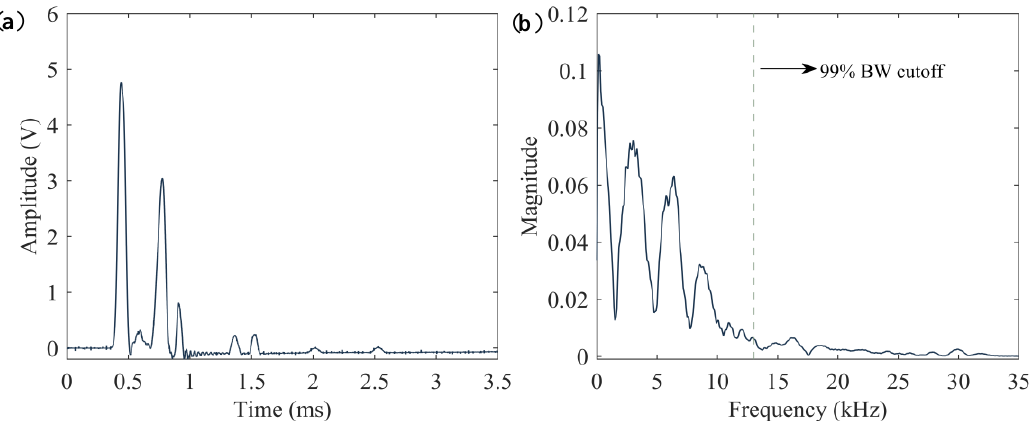
Figure 5. ( a ) Time waveform and ( b ) corresponding Fast-Fourier transform (FFT) measured during a control test to design a low-pass filter.